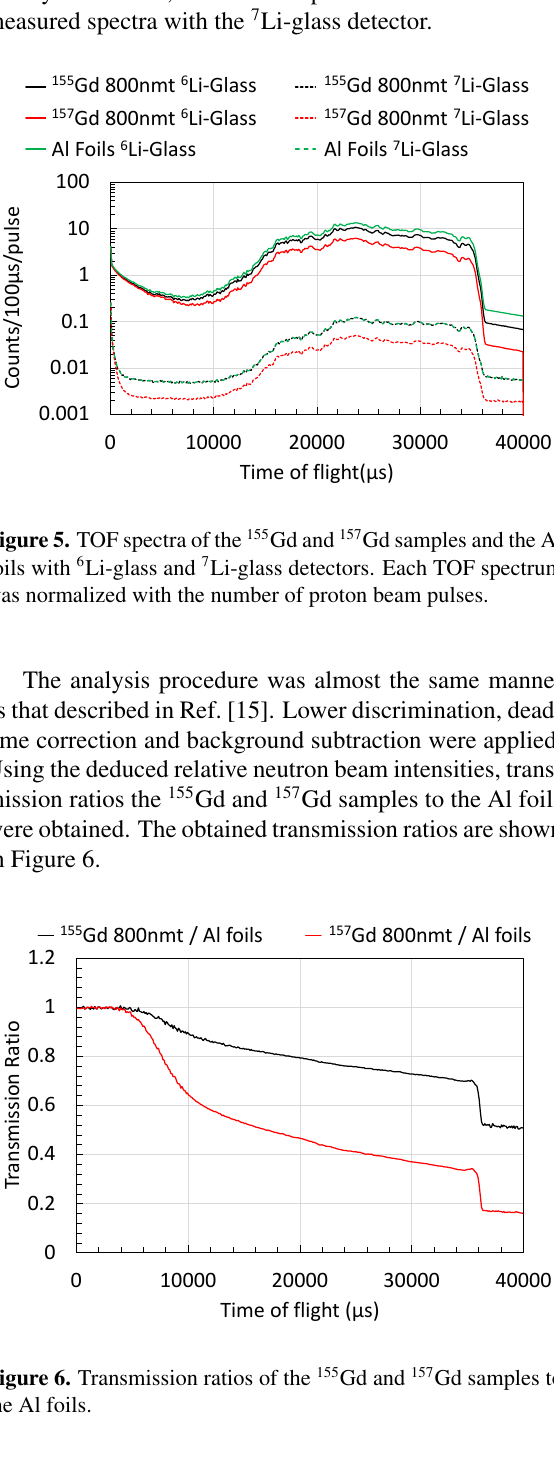
Table 2. Characteristics of the sample sheets.